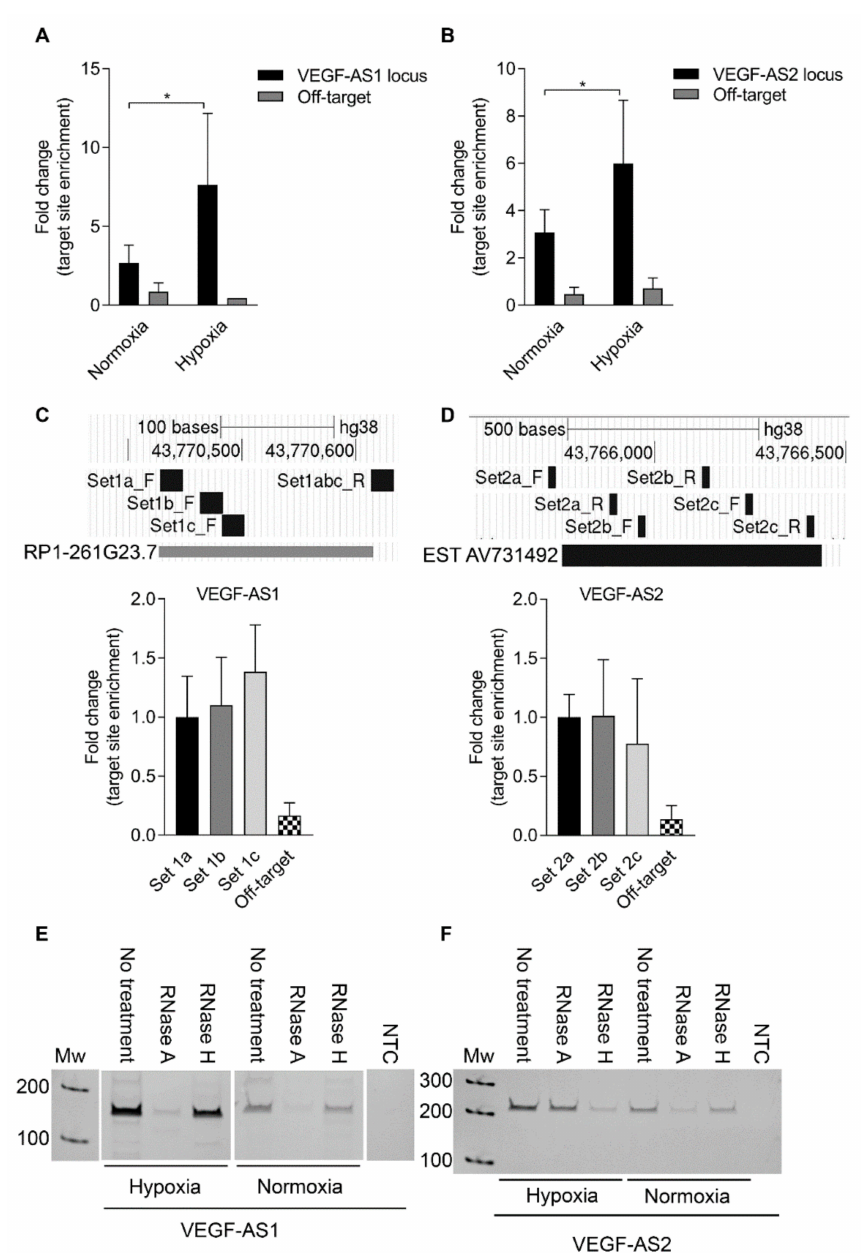
Figure 3. Both VEGF-AS1 and VEGF-AS2 localize to the VEGF-A promoter. ( A ) Fold change in VEGF-AS1 target locus enrichment at the VEGF-A promoter in normoxic and hypoxic EA.hy926 cells as determined by quantitative polymerase chain reaction (qPCR) after pulldown with antisense oligonucleotides with 3 (cid:48) -Biotin modifications. Beads only control is set to be 1. The data are presented as mean ± SD and standardized to inputs ( n = 3 independent experiments). Significance was measured by two-way ANOVA. * p < 0.05; ( B ) fold change in VEGF-AS2 target locus enrichment at the VEGF-A promoter in normoxic and hypoxic EA.hy926 cells as determined by qPCR after pulldown with antisense oligonucleotides with 3 (cid:48) -Biotin modifications. Beads only control is set to be 1. The data are presented as mean ± SD and standardized to inputs ( n = 3 independent experiments). Significance was measured by two-way ANOVA. * p < 0.05; ( C ) primer walking at the VEGF-A promoter. A qPCR analysis of VEGF-AS1 localization at the VEGF-A promoter in EA.hy926 cells after pulldown with antisense oligonucleotides with 3 (cid:48) -Biotin modifications. The data are presented as mean ± SD and standardized to inputs ( n = 2 independent experiments); ( D ) primer walking at the VEGF-A